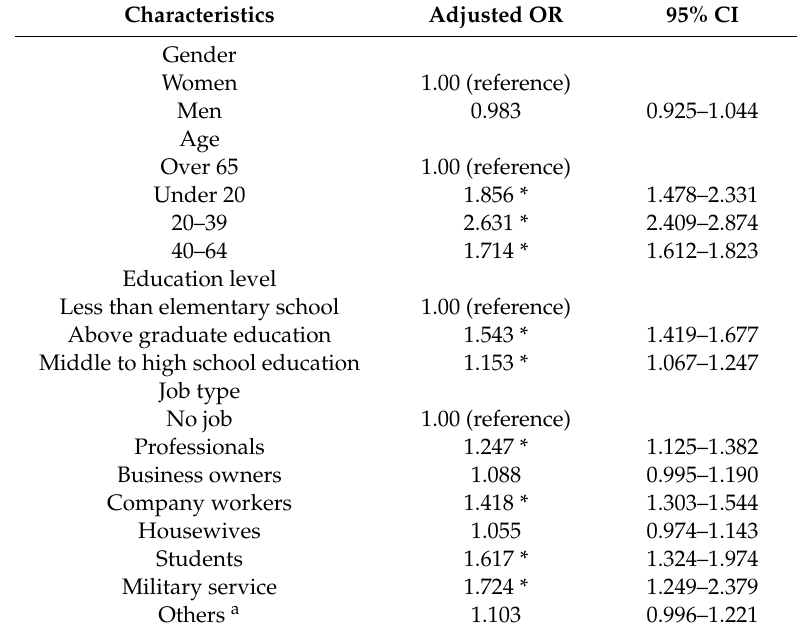
Table 3. Associated factors for patient accessing the Today’s Medication menu (N = 29,856). Characteristics Adjusted